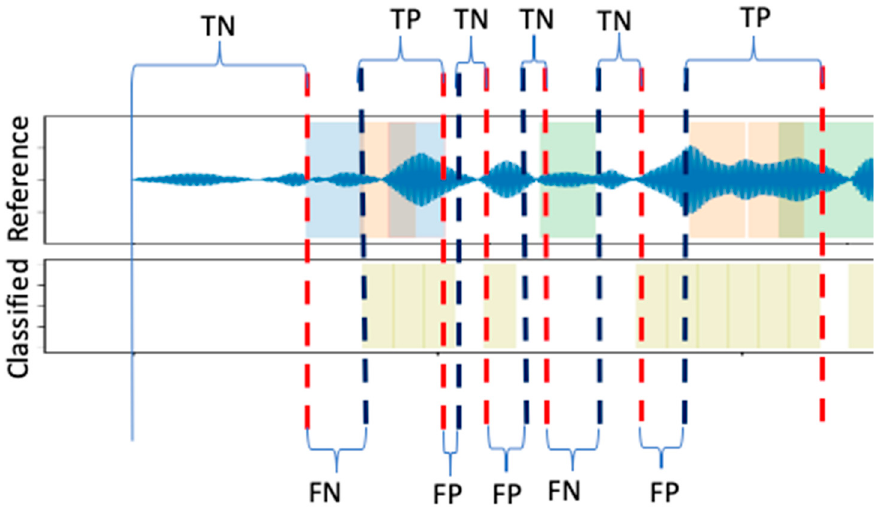
Figure 9. Illustration of the evaluation scheme.